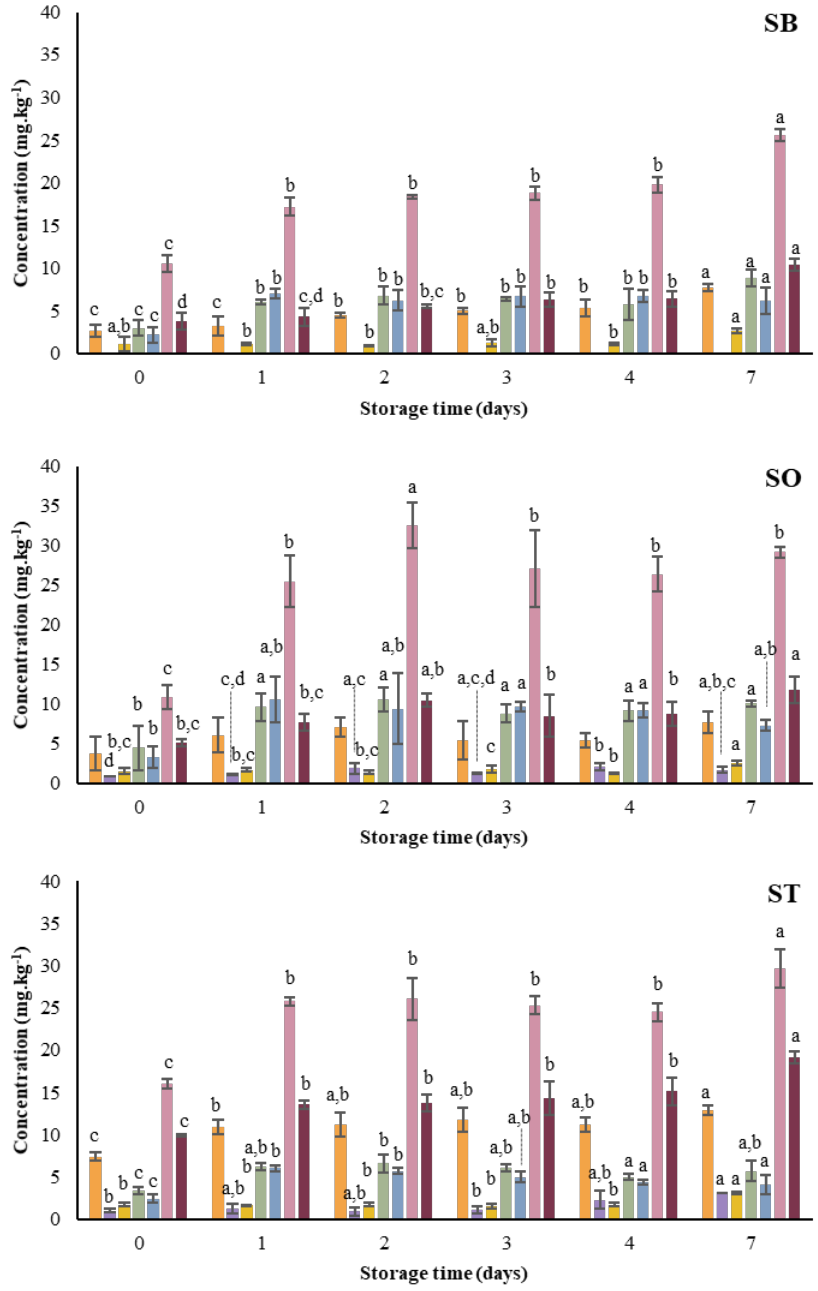
Figure 2. Biogenic amines, total amine, and biogenic amine index of canned sardines during storage at 4 ◦ C. For each parameter, different letters between columns show statistical differences between means ( p < 0.05).